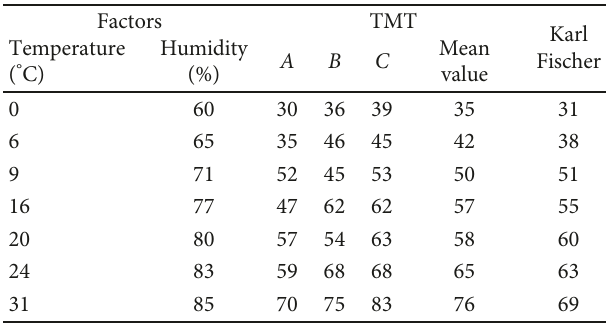
Figure 3: The curves of temperature titration. Table 6: Results of the water content ( μ g · g − 1 ) in jet fuels under di ff erent conditions.